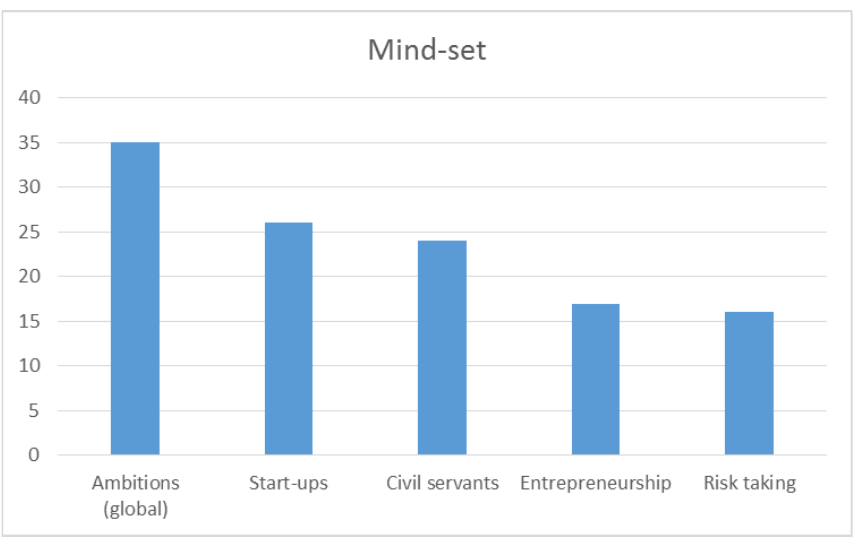
Fig. 9. Lack of entrepreneurial "spirit" according to number of